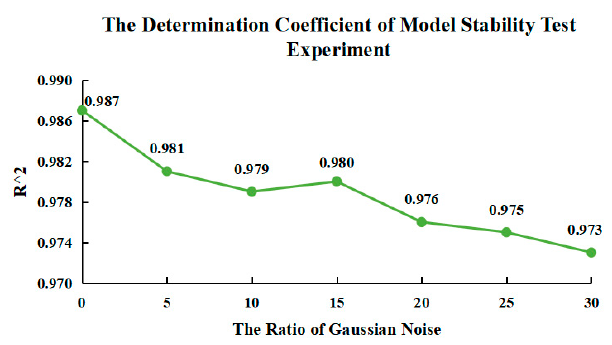
Figure 15. R 2 of the results for the model stability evaluation.